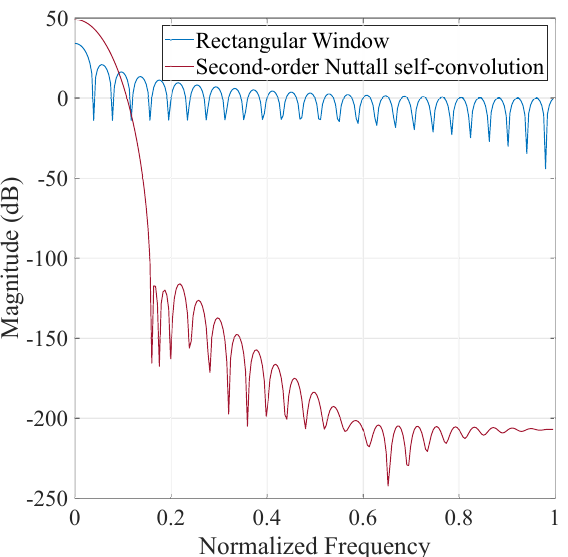
Figure 1. Side lobe performance of second-order Nuttall self-convolution window and rectangular window.